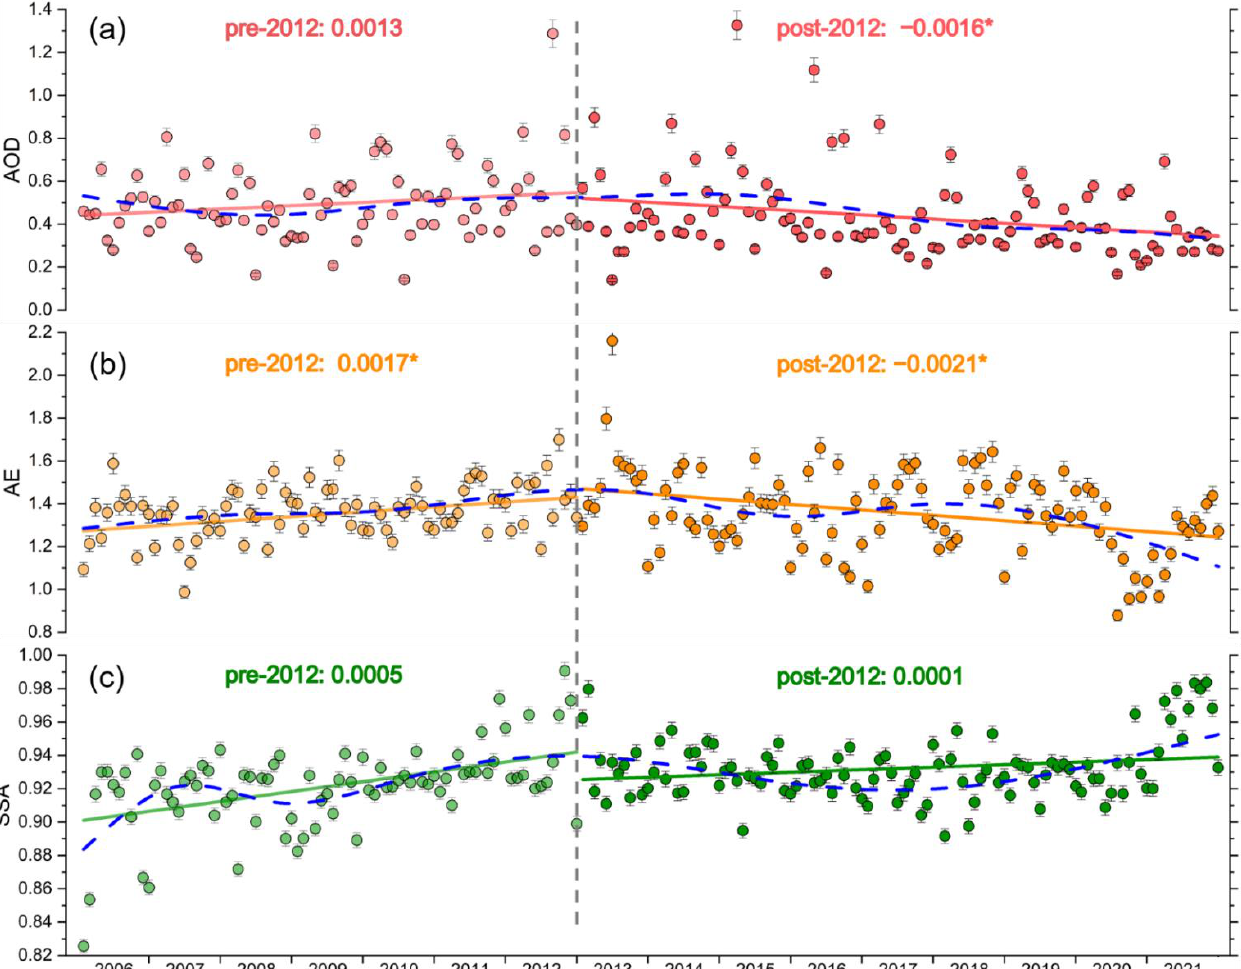
Table 2. Variance contribution rate (VCR) and correlation coefficient of the decomposed results.